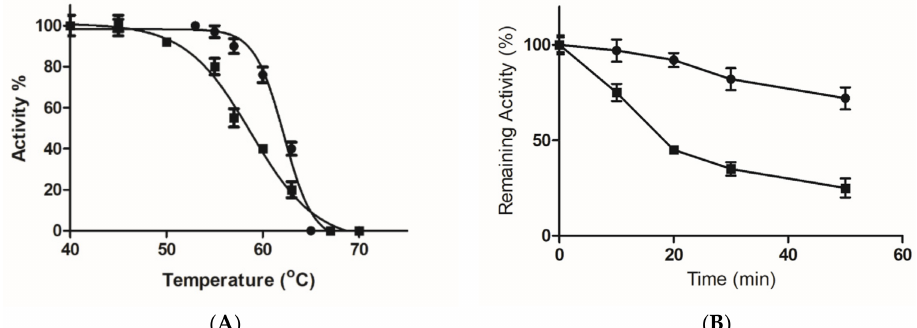
Figure 7. Effect of point mutation on thermal stability. ( A ). The residual activities of the wild-type enzyme ( • ) and the mutant enzyme Arg174Asn ( (cid:4) ) were measured after heat treatment at various temperatures ( ◦ C). ( B ). Time course of thermal inactivation of the wild-type enzyme ( • ) and the mutant enzyme Arg174Asn ( (cid:4) ) at 60 ◦ C. At indicated times, enzyme samples were removed and assayed for residual FDH